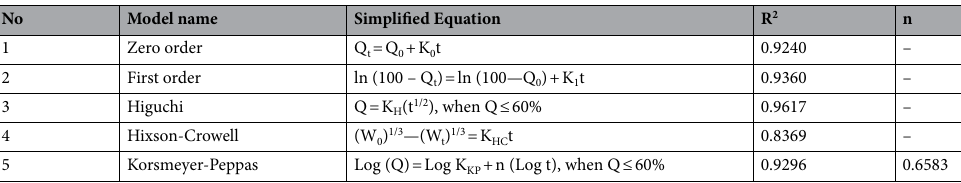
Table 2. The theoretical kinetic evaluation of the drug release profile of the CIP-loaded PEG–PLGA NP.